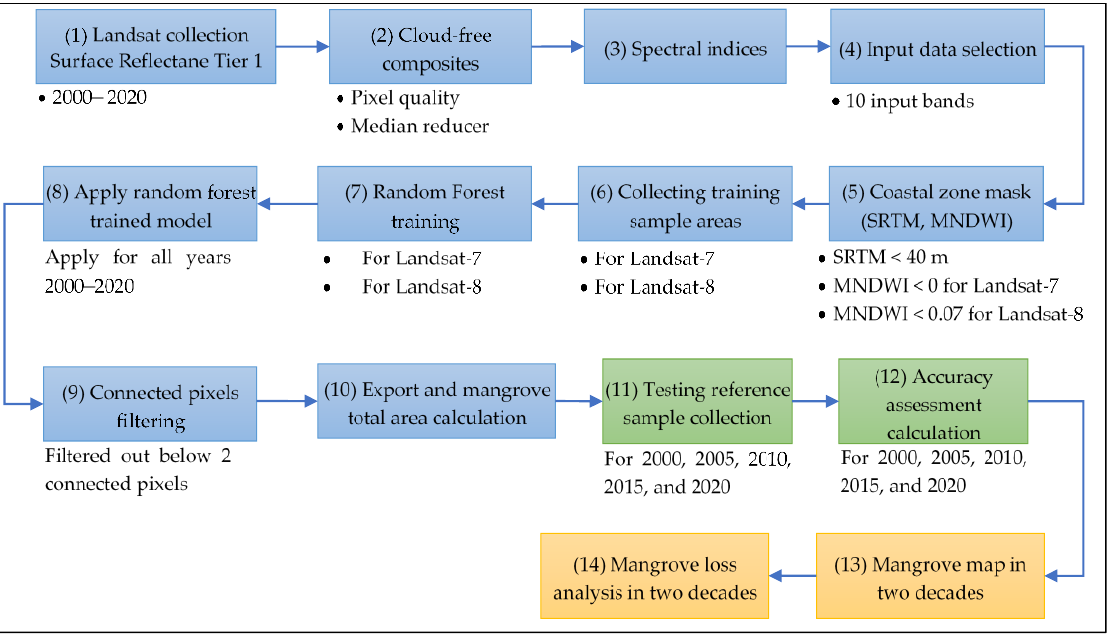
Figure 2. Research workflow, the blue boxes stand for all processing inside the Google Earth Engine (GEE), while the green and orange boxes stand for all processing in GIS software. SRTM and MNDWI denote Shuttle Radar Topography Mission and Modified Normalize Different Water Index, respectively.